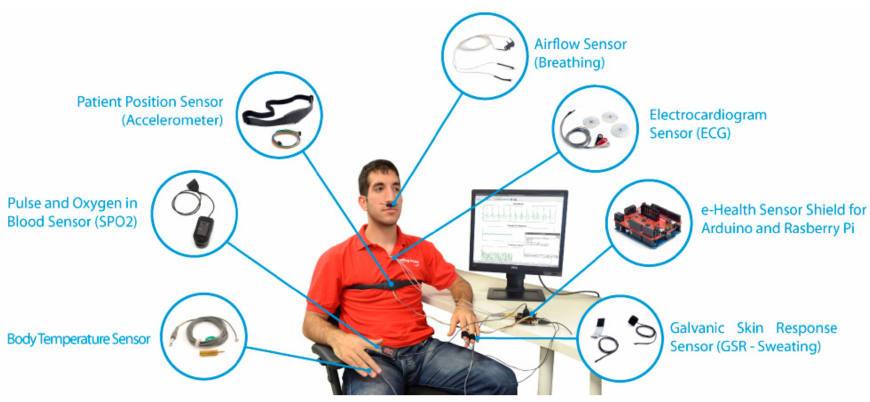
Figure 10. e-Health Sensor Platform for Biometric and Medical applications